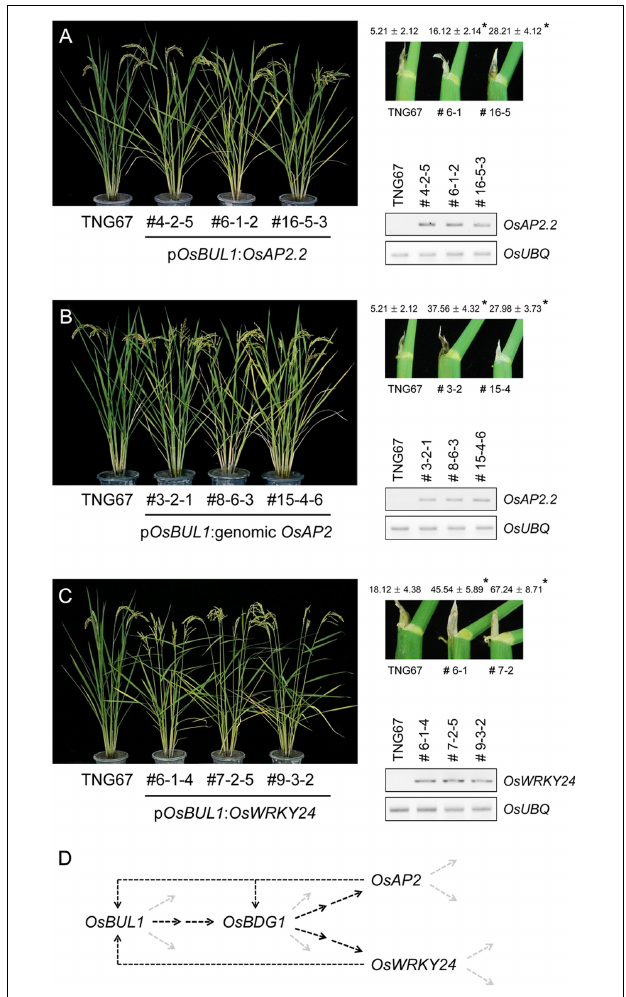
FIGURE 6 | Generation of transgenic rice plants expressing OsAP2 and OsWRKY24 under the control of OsBUL1 promoter. (A,B) Transgenic rice containing p OsBUL1 : OsAP2.2 , a short transcript of OsAP2 (Os10g41330) or genomic OsAP2 showed increased lamina inclination. The longer OsAP2.1 transcript was not detected in p OsBUL1 :genomic OsAP2 plants. Leaf angle was measured with the second leaf from the top of the main stem. (C) Transgenic rice with p OsBUL1 : OsWRKY24 showed significant increase in leaf angles. The third leaf angles in the WT and transgenic lines were measured. RNAs were extracted from collars for cDNA synthesis and RT-PCR. Values for leaf angles are given as means ± SD (degree; n = 10 to 18). ( ∗ P < 0.01, Student’s t -test). (D) Flow of genes acting in lamina inclination identified in this study. The dashed black lines were drawn based on results of expression analyses and transgenic